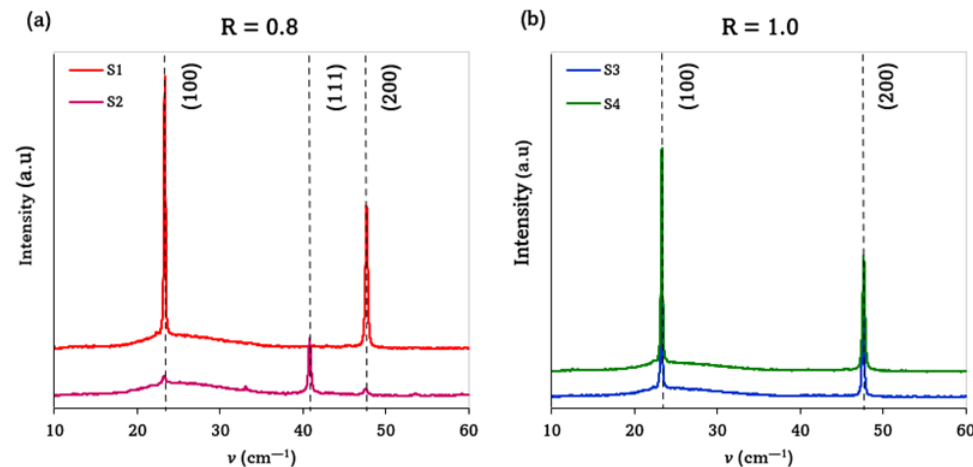
Figure 2. X-ray diffraction patterns of Cu 3 N films deposited at RT and 50 W in ( a ) mixed Ar + N 2 and ( b ) pure N 2 environments.